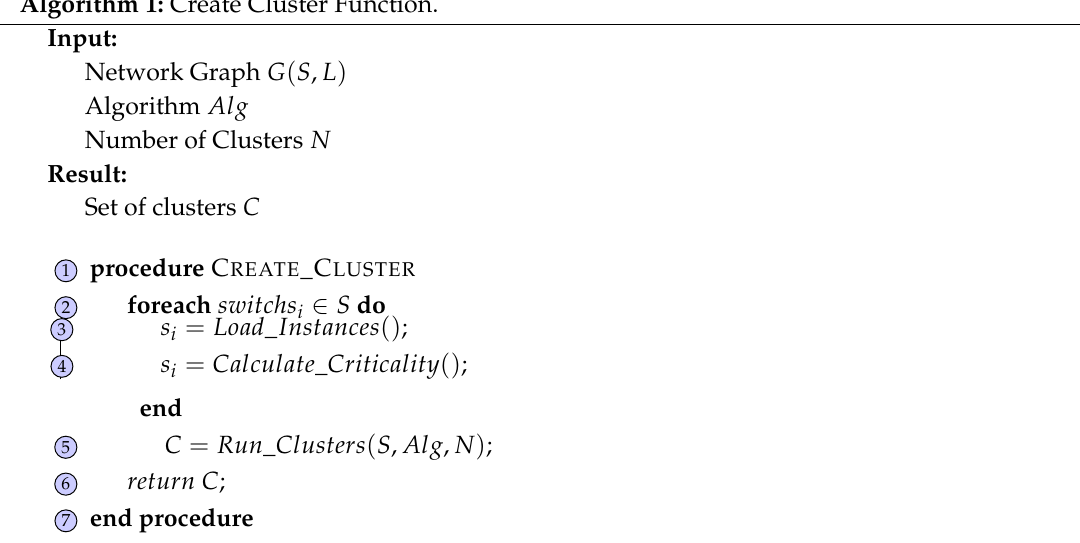
Algorithm 1: Create Cluster